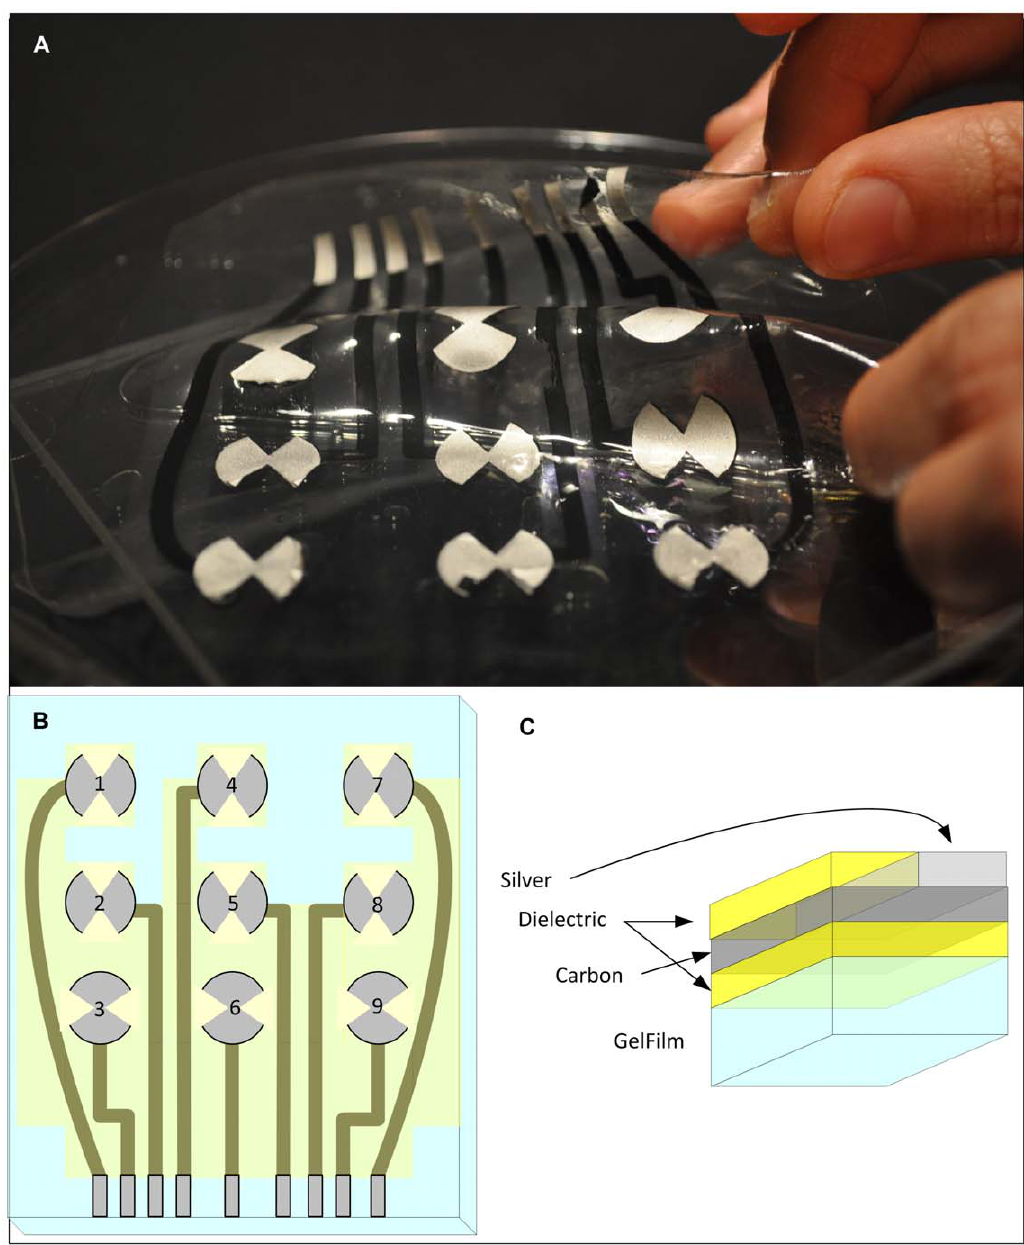
Figure 1. The polymer thick film organic substrate (PTFOS) flexible electrode set. ( A ) Image, ( B ) layout and ( C ) sectional cut of the PTFOS. The 4 layers are made of dielectric, carbon, silver and